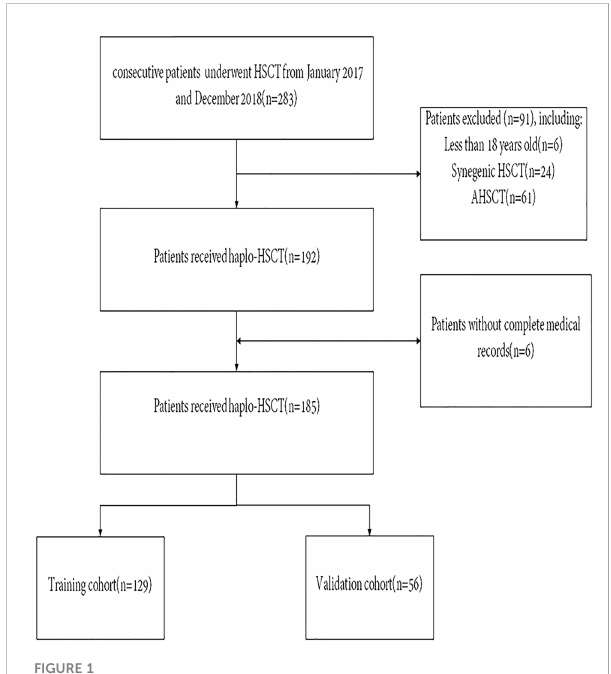
FIGURE 1 Patient fl ow diagram. HSCT, Hematopoietic Stem Cell Transplantation. AHSCT, Autologous Hematopoietic Stem Cell